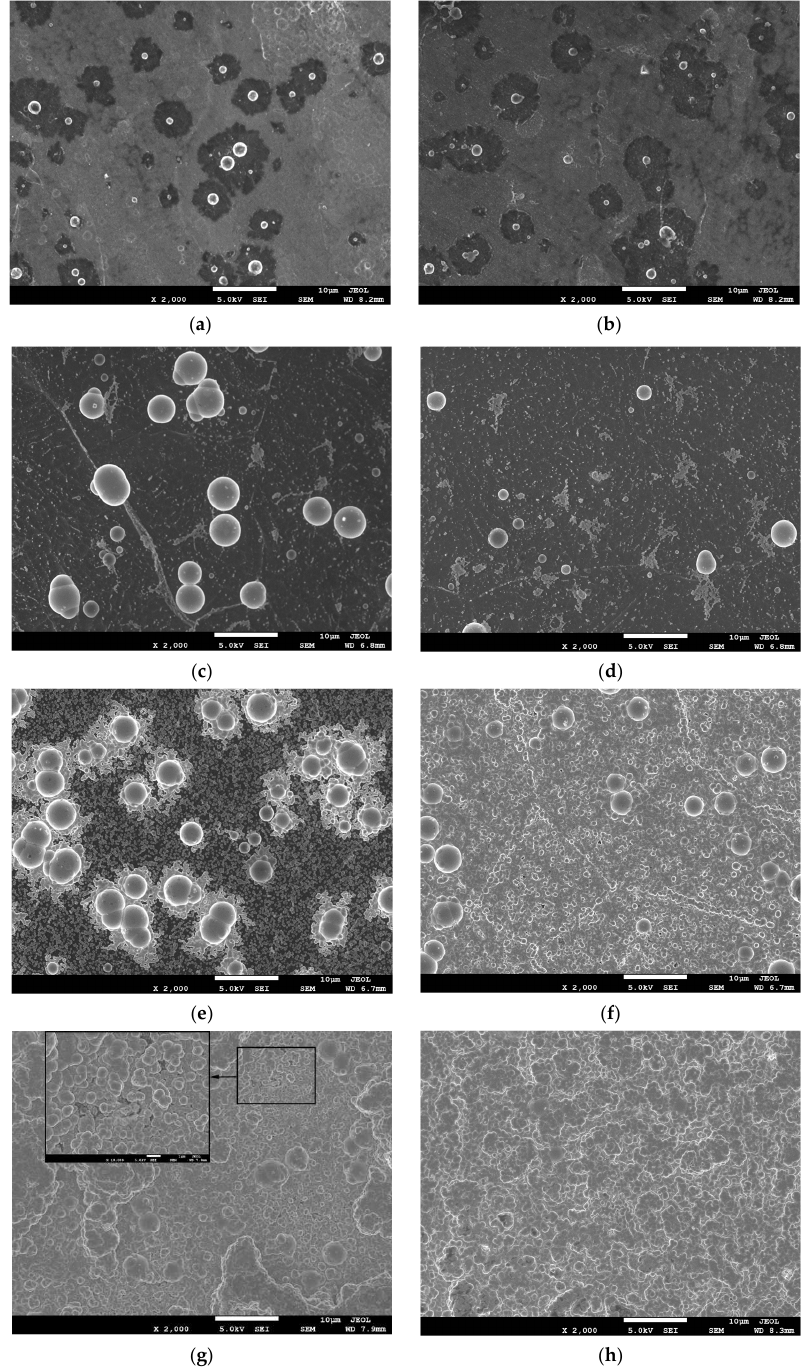
Figure 4. The evolution of the upper and lower surface morphology of the Mg–Li alloy with reac- tion time. Upper surface: ( a ) 2 min, ( c ) 10 min, ( e ) 20 min, ( g ) 45 min and its partial enlargement; Lower surface: ( b ) 2 min, ( d ) 10 min, ( f ) 20 min, ( h ) 45 min.